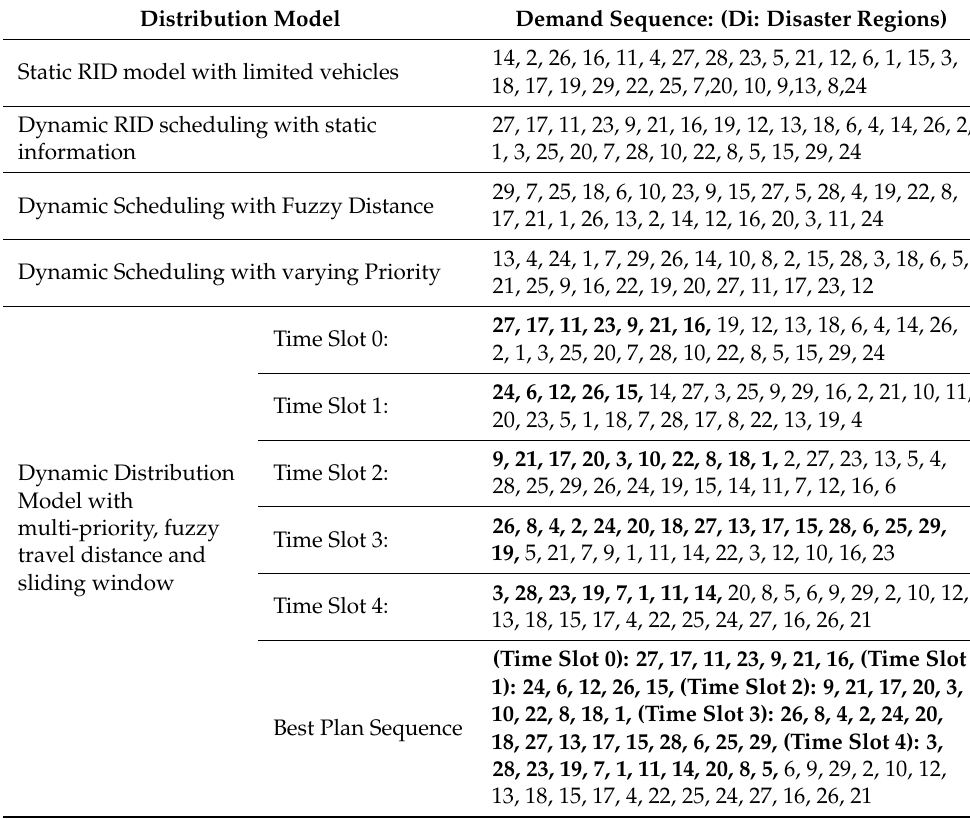
Table 7. Optimum distribution sequence of RID models. Distribution